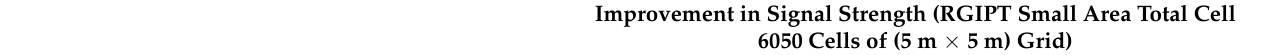
Figure 15. ( a ) Number of cells between the high and low-populated areas according to the two dB m sets for the three locations of the tower. ( b ) Number of cells for the whole area for the three loca- tions of the tower. Table 1. Percentage change in locations “1” and ”2” from cell values of the main location.